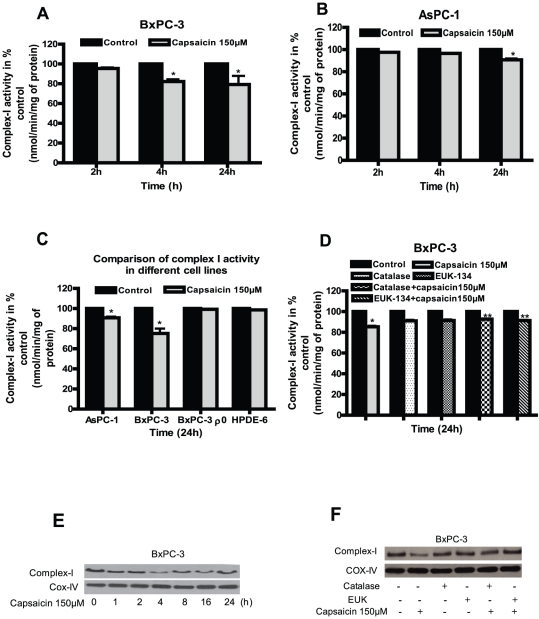
Involvement of ETC complex-I in capsaicin mediated ROS generation.Enzymatic activities of mitochondrial complex I was determined in the pure mitochondria isolated from control and 150 µM capsaicin treated (A) BxPC-3 and (B) AsPC-1 cells for 2, 4 and 24 h. (C) Comparison of complex-I activity in AsPC-1, BxPC-3, BxPC-3 ρ0 and HPDE-6 cells treated with 150 µM for 24 h. (D) Capsaicin mediated decrease of complex-I activity was prevented by pre-treatment of BxPC-3 cells with catalase (2000 U/ml) and EUK-134 (50 µM) for 1 h followed by 150 µM capsaicin for 24 h. Results are expressed over control as mean ± SD (n = 3) of three independent experiments. *Statistically different compared with control (P<0.05) and **statistically different when compared with capsaicin treatment (P<0.05), as analyzed by one-way ANOVA followed by Bonferroni's post-hoc test. (E) Complex-I protein expression was determined by immunoblotting using pure mitochondrial protein isolated from control and 150 µM capsaicin treated BxPC-3 cells for the indicated time periods or (F) 1 h pre treatment with catalase (2000 U/ml) or EUK-134 (50 µM) followed by 150 µM capsaicin for 24 h. Immunoblotting for each protein was performed three times independently and similar results were obtained. The blots were stripped and reprobed with anti-Cox-IV for mitochondrial proteins to ensure equal protein loading.